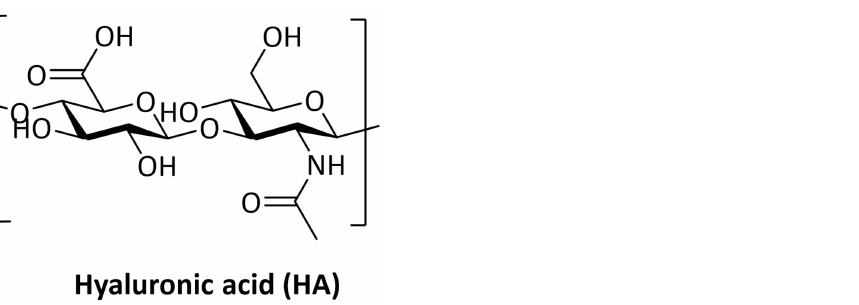
Figure 1. Chemical structure of Hyaluronic Acid. Created with ChemDraw Software version